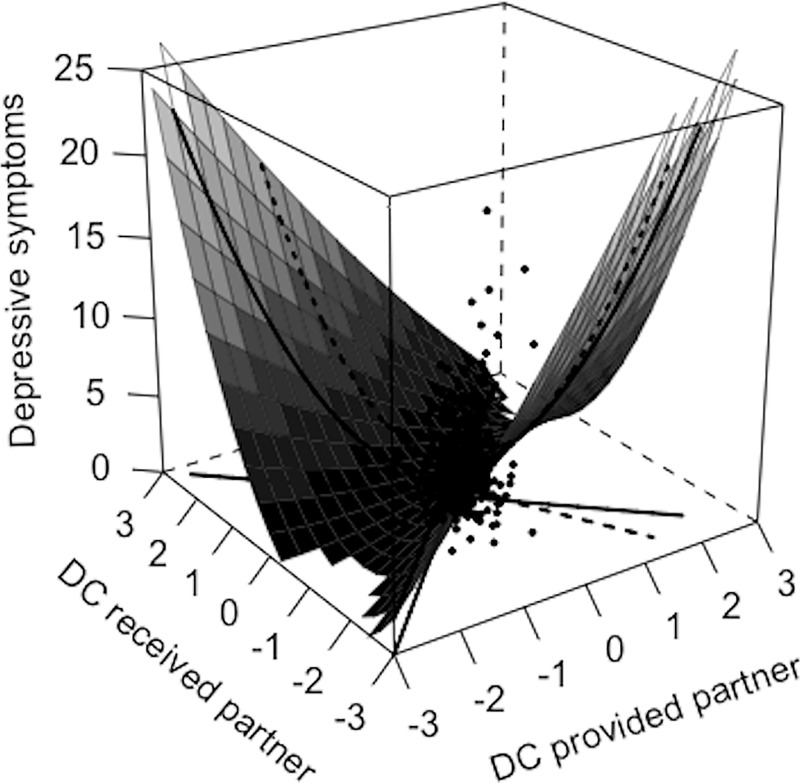
Regression of men’s depressive symptoms on women’s perceived equity (partner effects).Note. DC = dyadic coping. Significant curvilinear association between women’s equity and men’s depressive symptoms (partner effect) as visible by lower depressive symptoms in men along the line of equity as perceived by their female partners (front to back corner) where provided and received dyadic coping are perceived to be the same. Linear associations were not significant as visible by higher depressive symptoms in either direction of inequity (i.e., in the case of overbenefit (received > provided DC; left corner) or underbenefit (received < provided DC; right corner)).